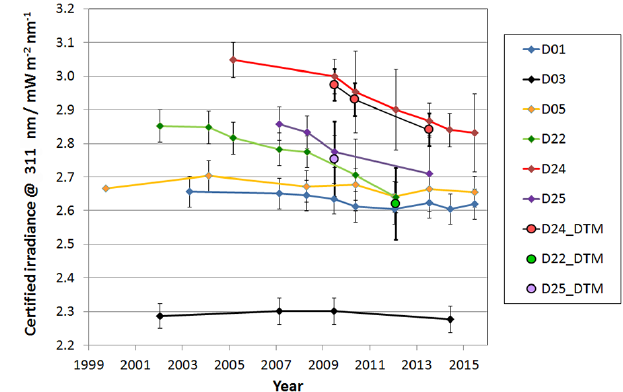
Figure 3. Time series of the raw counts (in units counts per cycle) at 311nm recorded by Brewer #107 spectrophotometer in measure- ments of a selection of 1000W lamps. The lamps marked with an asterisk are primary standard lamps regularly recalibrated in VTT MIKES Metrology.